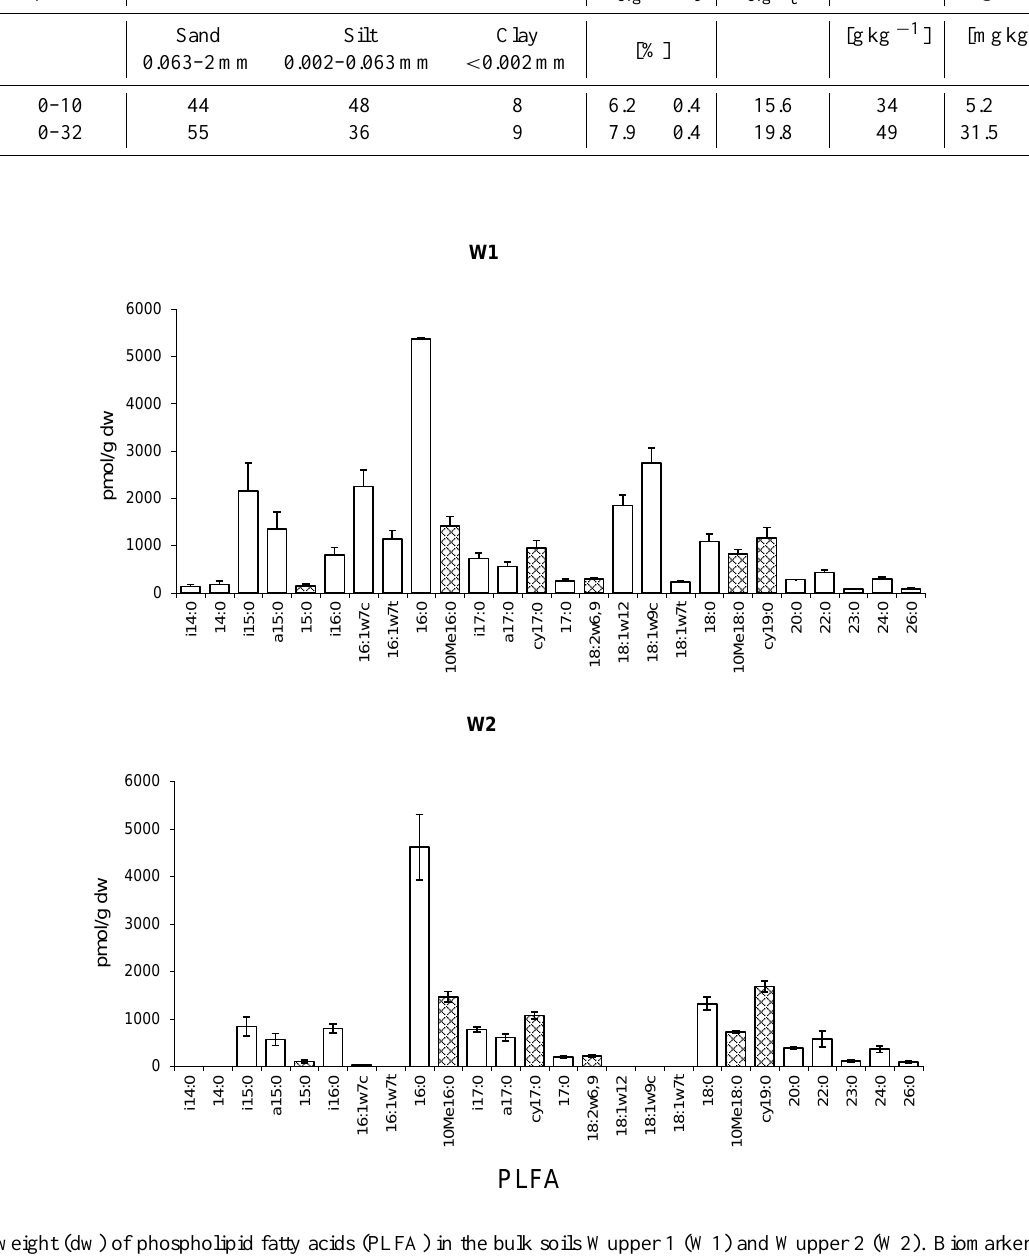
Fig. 3. Dry weight (dw) of phospholipid fatty acids (PLFA) in the bulk soils Wupper 1 (W1) and Wupper 2 (W2). Biomarkers for sulfate reducing bacteria are cross